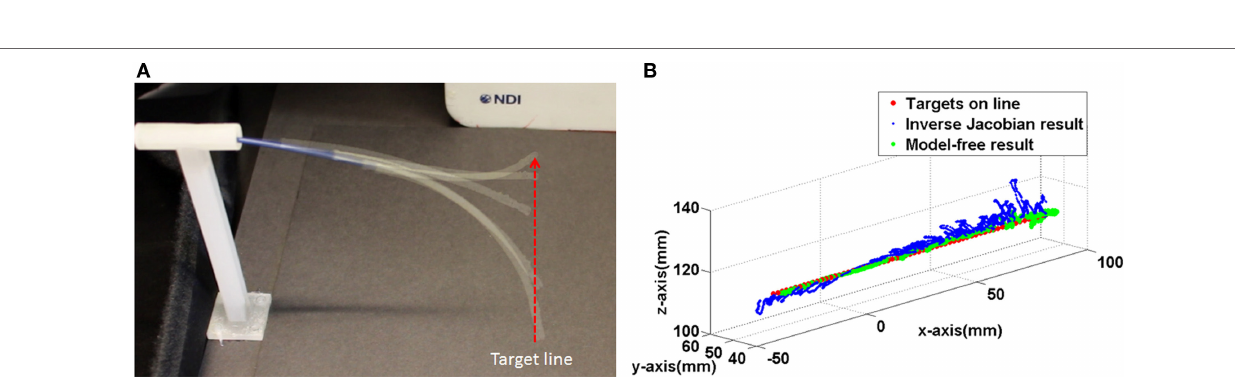
FigUre 13 | (a) The captured catheter shape during following the target line (B) trajectories of the both controller during following the target line.